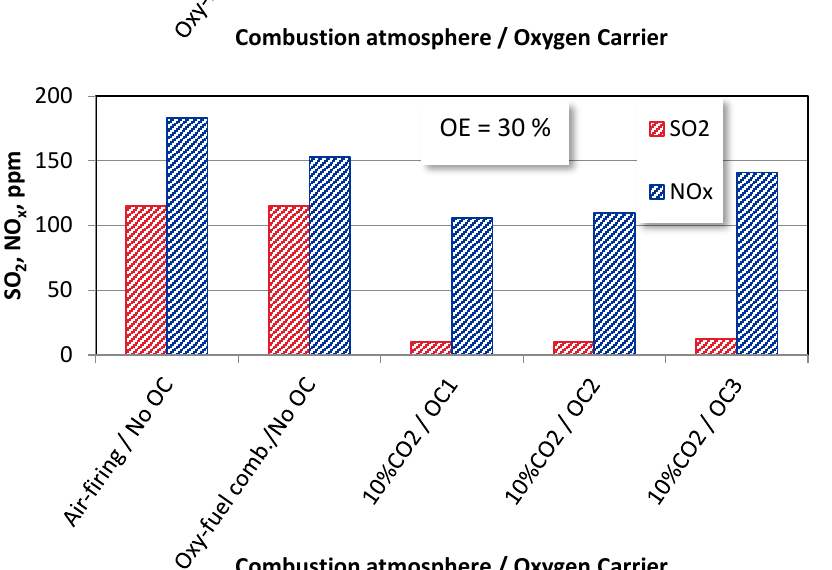
Figure 9. The effect of oxygen excess on SO 2 and NO x emissions wood chips combustion under different combustion modes (T = 1100 K).